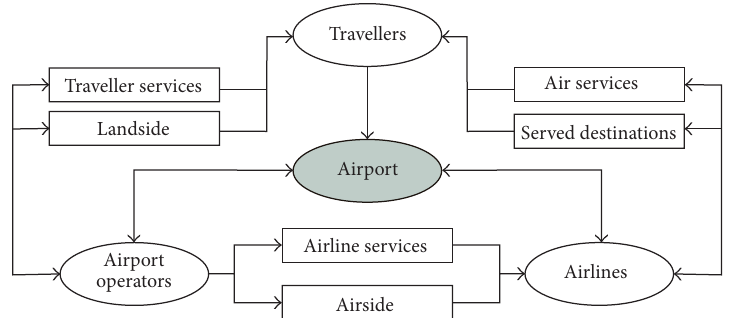
Figure 1: Relationships linking airport operators, airlines, and travellers with respect to the